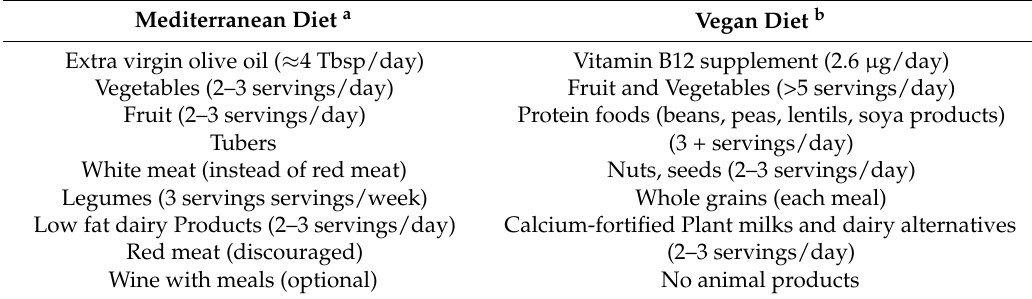
Table 1. Dietary Interventions: Mediterranean Diet vs. Vegan Diet. Mediterranean Diet a Vegan Diet